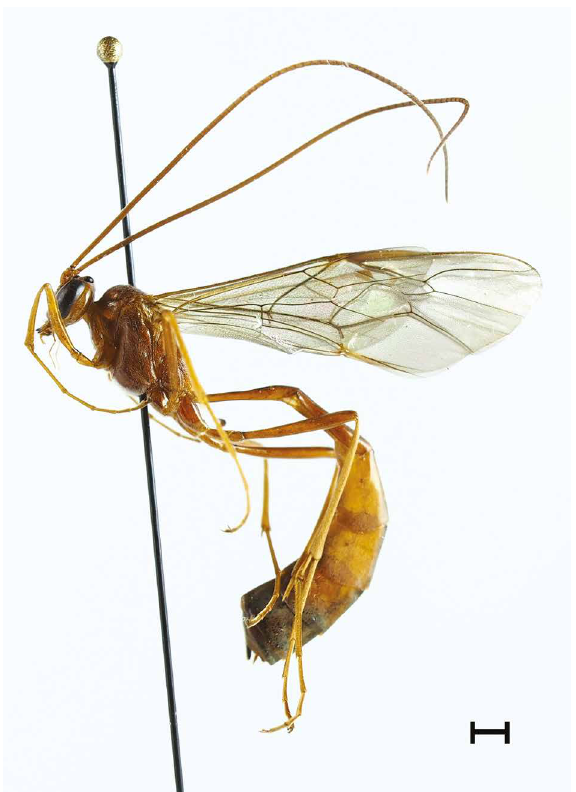
Fig. 8. Enicospilus intermedius sp. nov., holotype, ♀ (NHRS-HEVA000008154), habitus, lateral view. Scale bar = 1